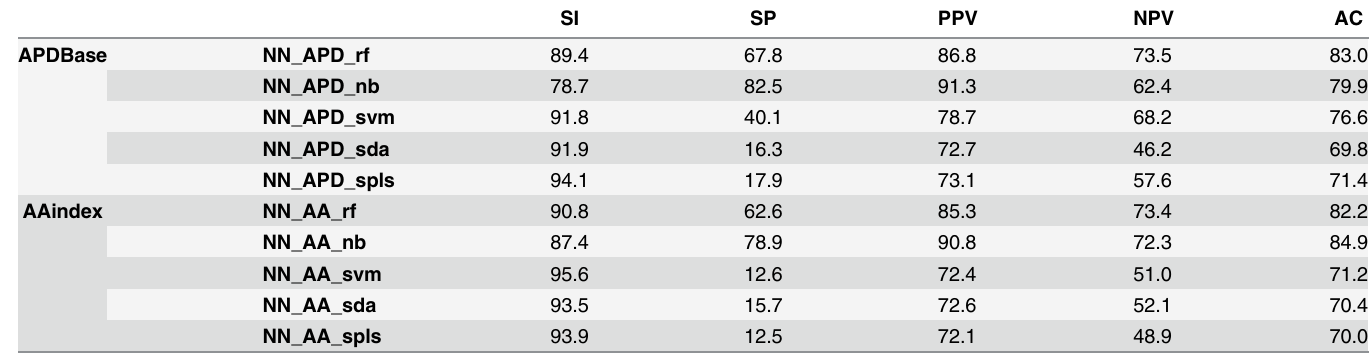
Table 2. External validation sequences dataset classification results (%) for the selected neural networks obtained through APDBase and AAindex encoding, after feature selection with one of the internal classifiers, rf, nb, svm, sda and spls. Where SI is the sensitivity, SP the specificity, PPV the positive predictive value, NPV the negative predictive value and AC the overall accuracy, averaged after 10-fold stratified